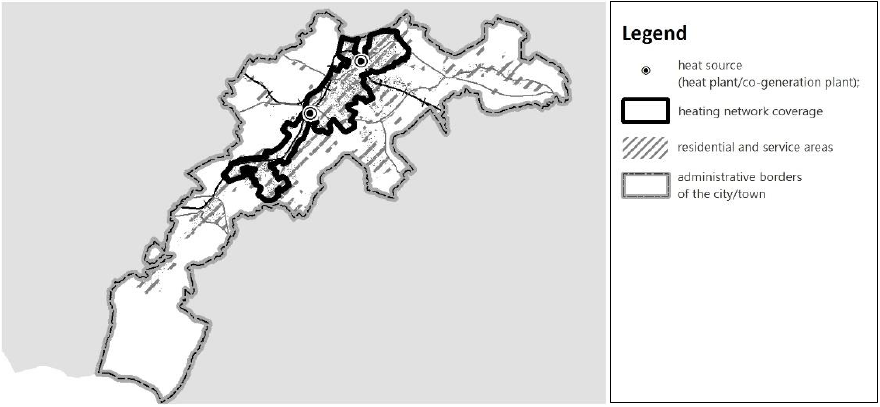
Figure 4. Areas intended for housing and service development, and the range of the district heating network in Jelenia Góra. * HSAs—housing and service areas.